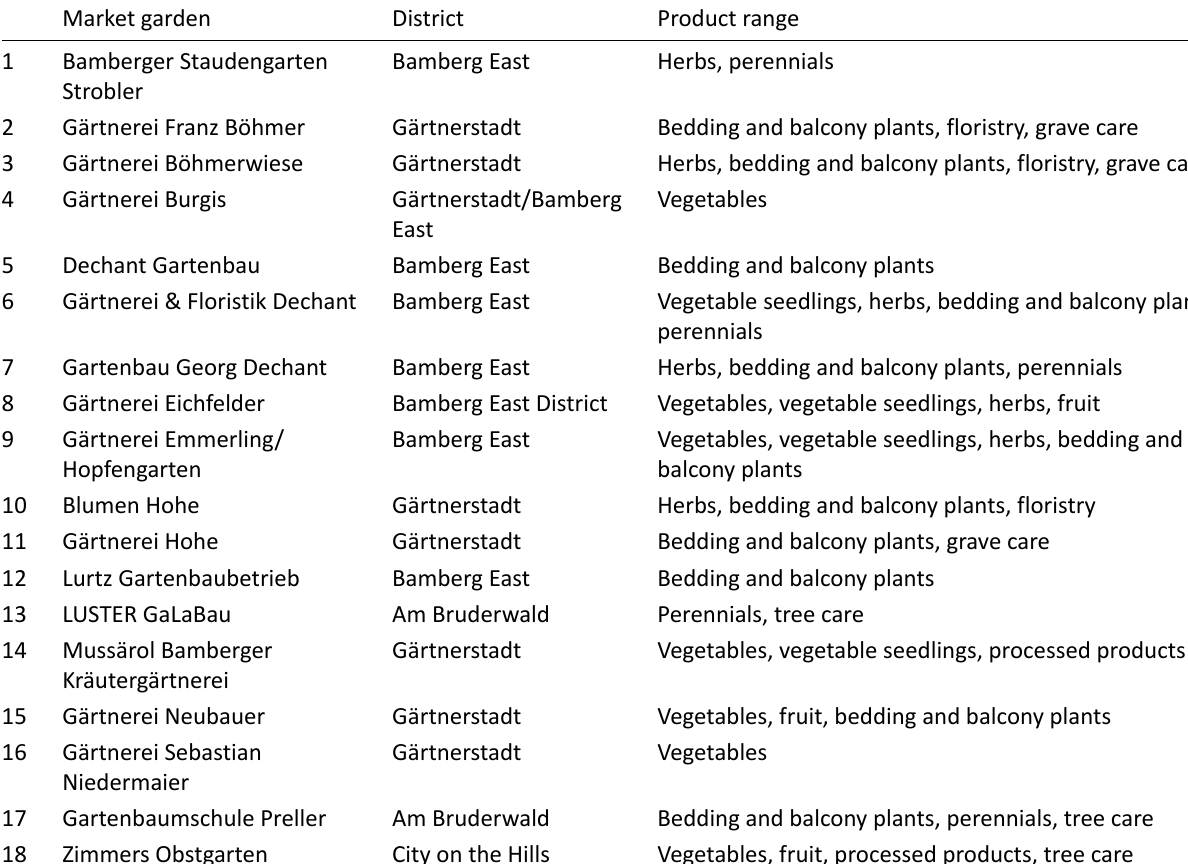
Table 1. Bamberg gardeners within the IG Bamberger Gärtner. Market